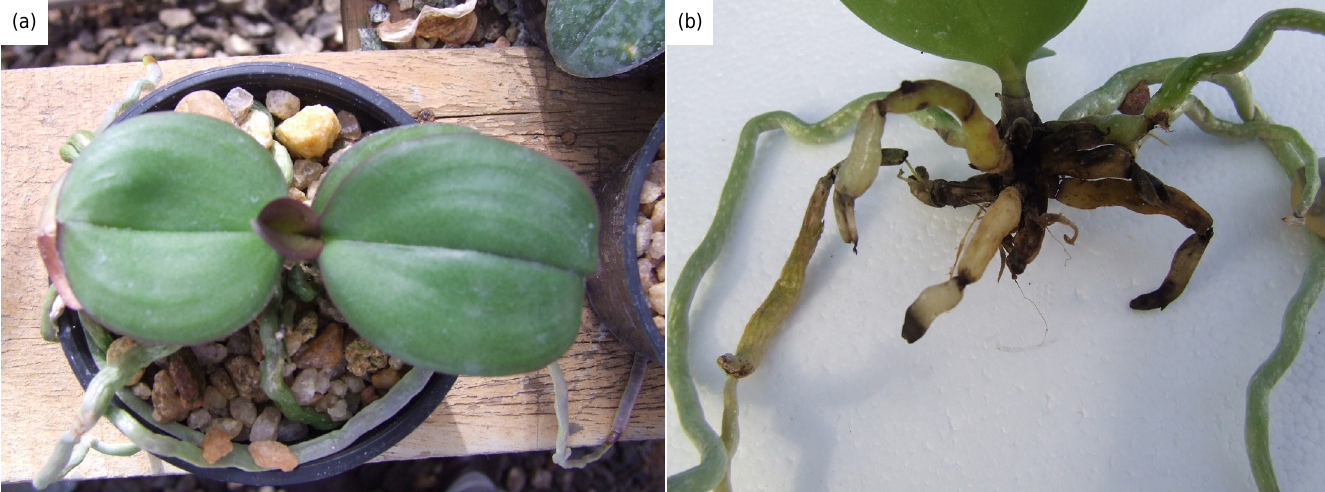
Figure 1. Initial visual symptom of Zn deficiency in Phalaenopsis spp. plant, characterized as limited growth of the last leaf, induced by application of the highest rate of P and a zero rate of Zn (a); and the root system characterized by limited growth and necrosis in the root tips (b) of the same plant with leaf